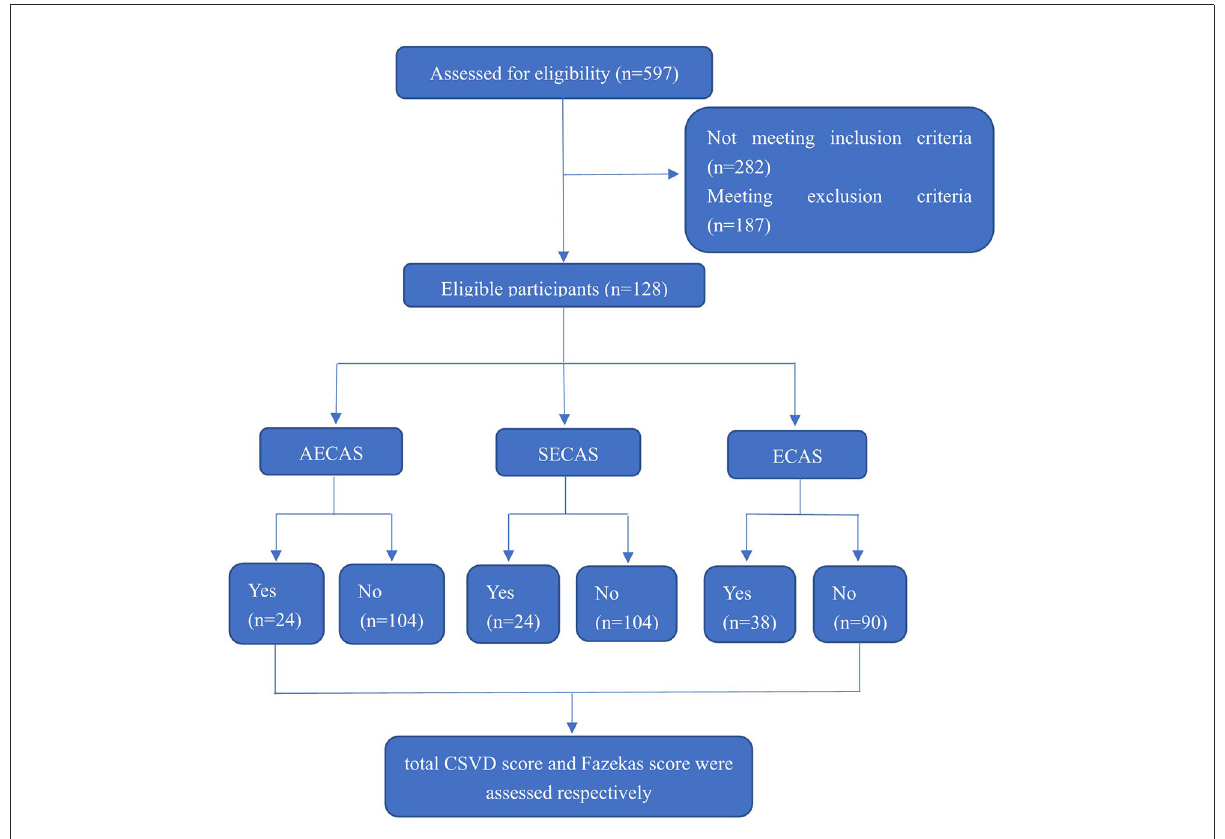
FIGURE1 Enrollment and outcomes. CSVD, cerebral small vessel disease; AECAS, asymptomatic extracranial artery stenosis; SECAS, symptomatic extracranial arterial stenosis; ECAS, extracranial artery